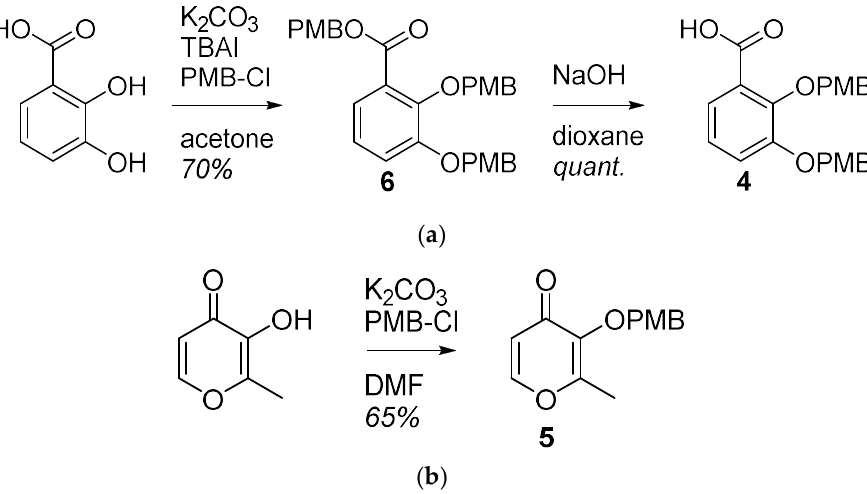
Figure 3. Synthesis of the bidentate ligands precursors ( a ) 4 is obtained from the 2,3-dihydroxybenzoic acid; ( b ) 5 is obtained from the 3-hydroxy-2-methyl-4 H -pyran-4-one (maltol).